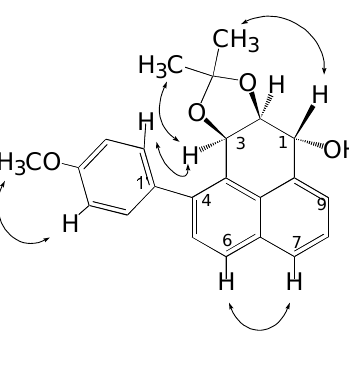
Figure 2. NOE's in 2,3-acetonide derivative of (1 R* ,2 S* ,3 R*